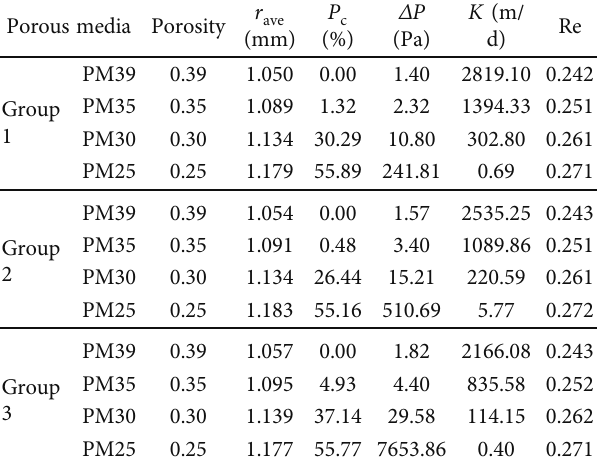
Table 1: Properties of the porous media with di ff erent cementation